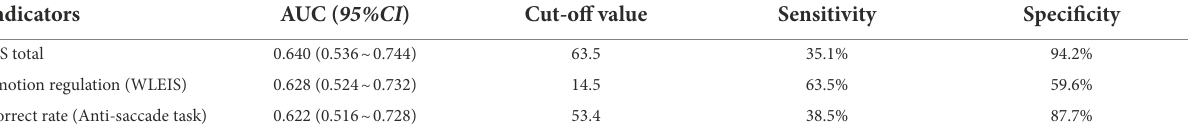
TABLE 3 Discriminating HIGD from LIGD by ROC analyses.